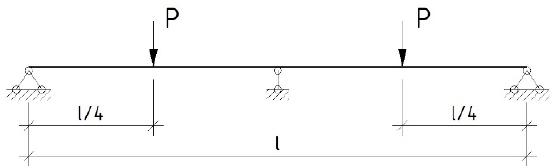
Figure 1. Continuous beam loaded with point load in the middle of each span. Intact structure.